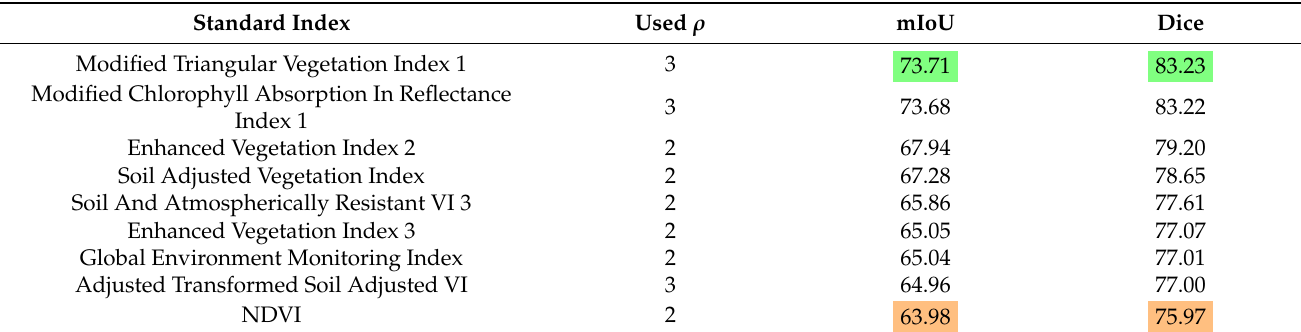
Table 2. Synthesized standard indices performances: the nine best models are